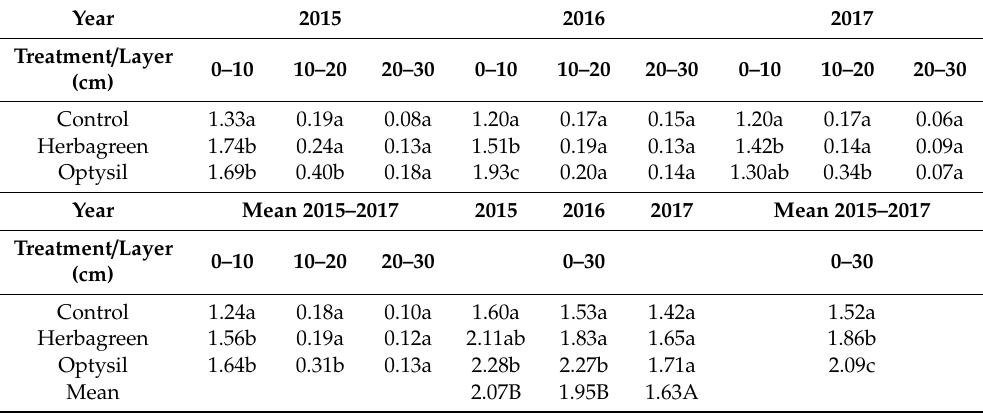
Table 3. Dry root mass of plants (RDM; kg / m 2 ) in the soil layer up to 30 cm depending on silicon-containing fertilizer treatments (Herbagreen, Optysil) in the years of study.